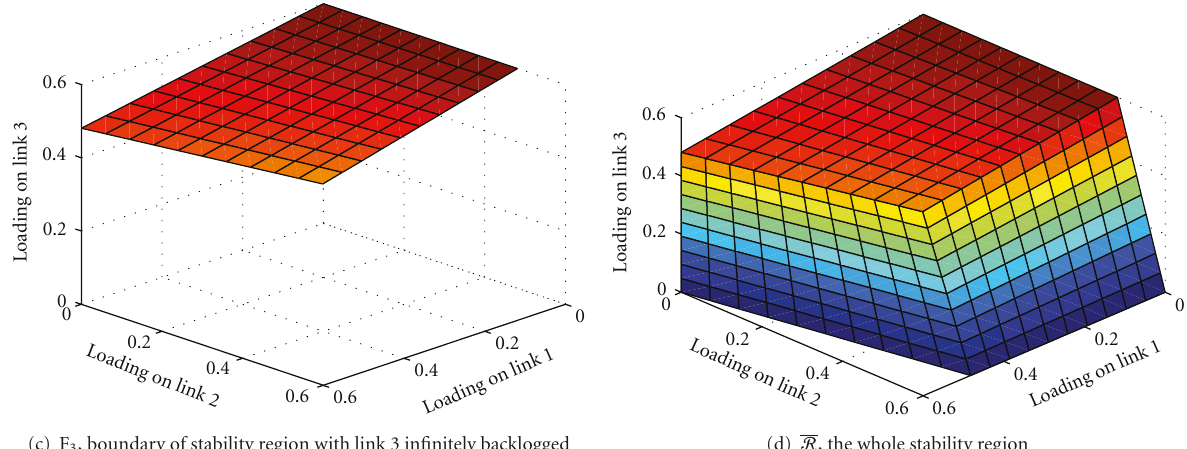
Figure 13: Stability region of FRASA under partial interference with M = 3, transmission probabilities 0.6 and topology in Figure 12(a) by Theorem